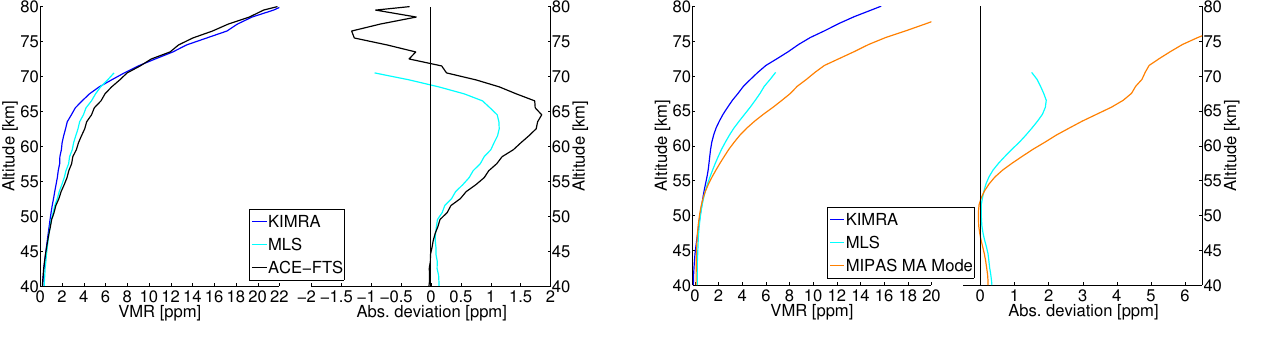
Fig. 15. Comparison of KIMRA with ACE-FTS and MLS using the collocation criteria R =1000km and 1 PV=20%. 22 days with co- incidences were found. Left panel: mean profiles derived according to Sect. 5.1. Right panel: deviation between the KIMRA and the satellite profiles calculated with Eq. (20).